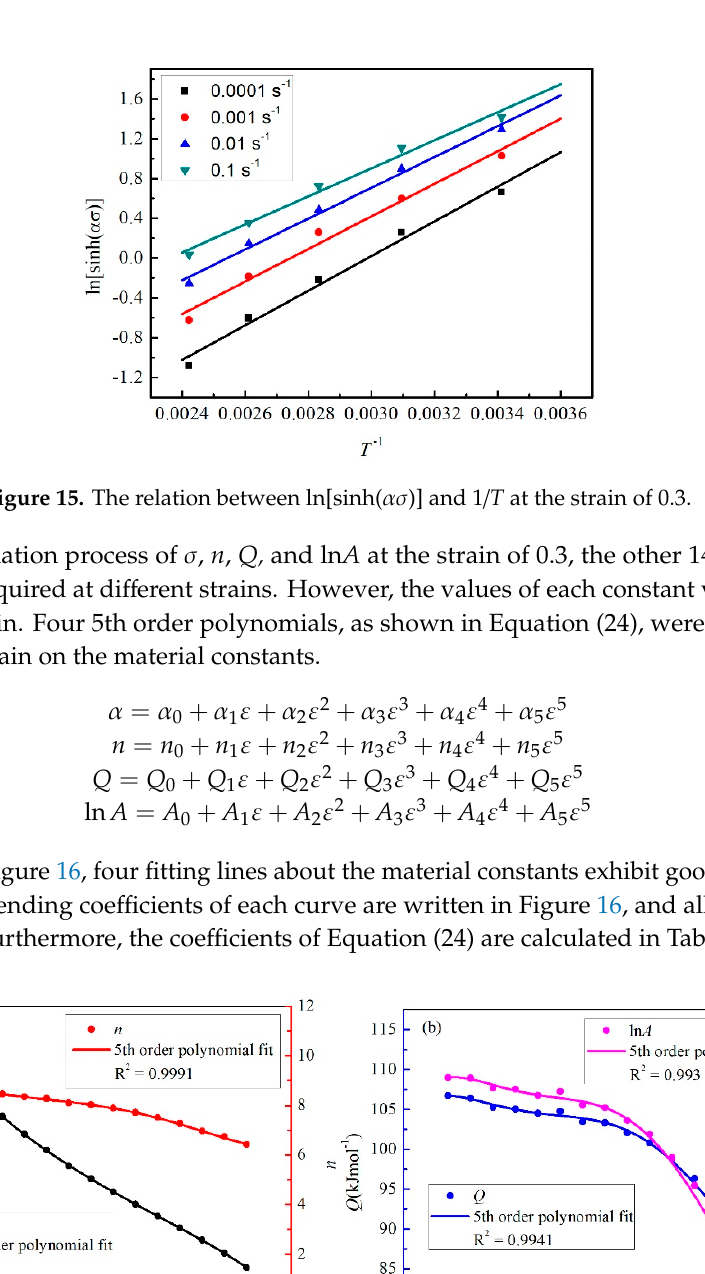
Figure 14. The relation between ln[sinh( ασ )] and ln ε  at the strain of 0.3.